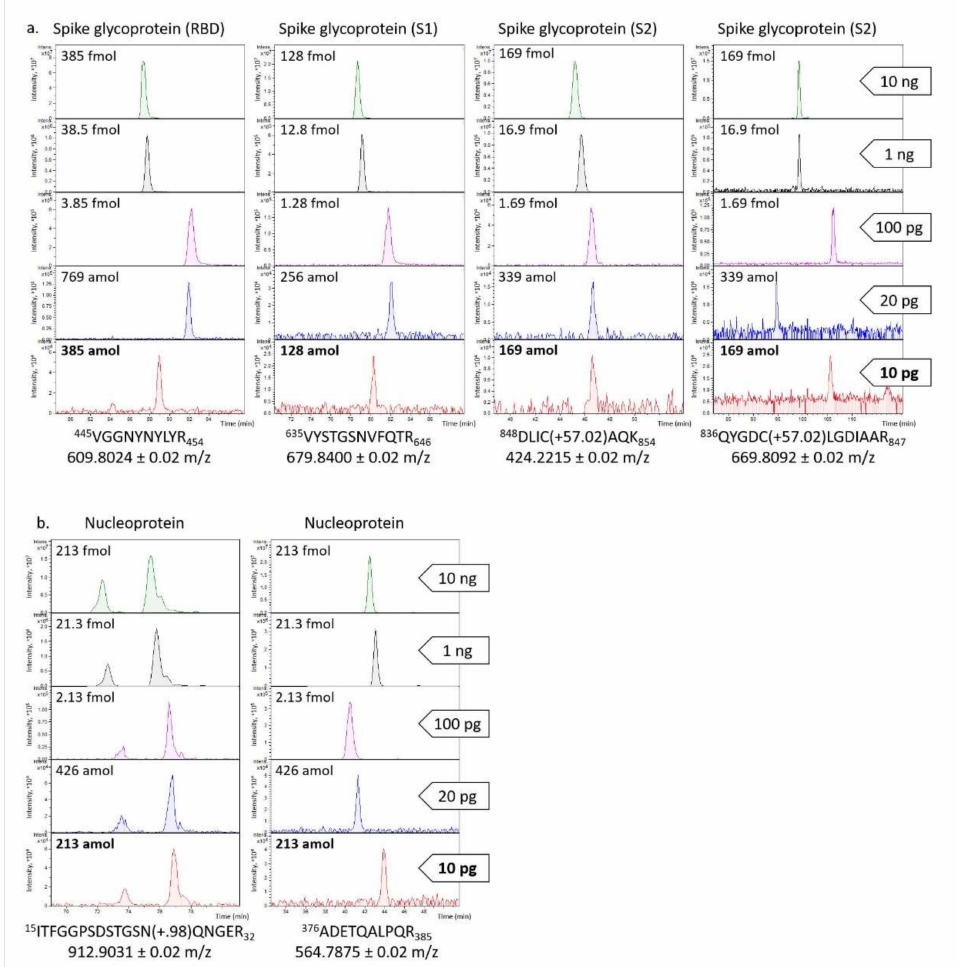
Figure 2. Sensitivity of SARS-CoV-2 tryptic peptides for LOD. Ion chromatograms (ion intensity on the Y-axis, retention time on the X-axis) of four ions of the spike glycoprotein and two ions of the nucle- oprotein after the injection of purified SARS-CoV-2 proteins in different quantities (from 10 ng to 10 pg) in order to visualise the correlation between the amount of protein analysed by nLC-ESI-MS/MS and ion intensity. ( a ) For the spike glycoprotein, four peptides were chosen: 445 VGGNYNYLYR